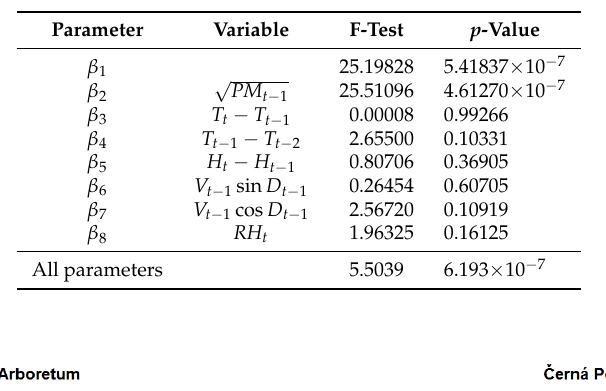
Table 4. Tests of equal parameters and model comparison.